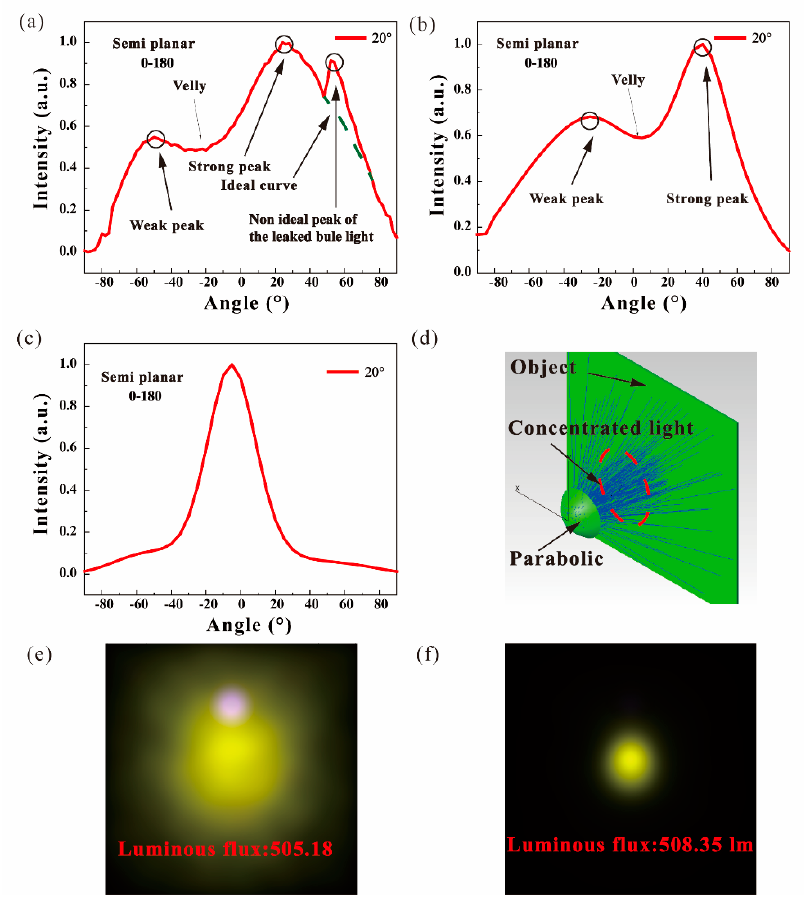
Figure 10. Light intensity distribution of ( a ) experiments, simulations ( b ) before and ( c ) after opti- mization; ( d ) simulation models of modulated ATFPCs, true color images of ATFPCS ( e ) without and ( f ) with a reflector.